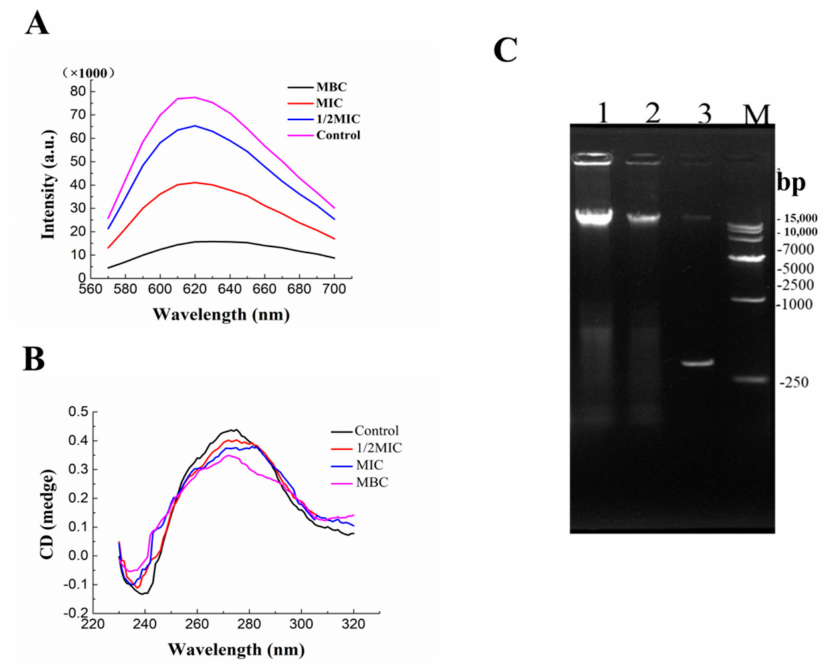
Figure 6. The fluorescence spectra ( A ), CD spectra ( B ) and DNA gel electrophoresis ( C ) of P. syringae treated with juglone (Each bar represents the mean ± SD of three independent experiments. Lanes M, 1, 2, 3 were corresponding to markers, control, MIC and MBC